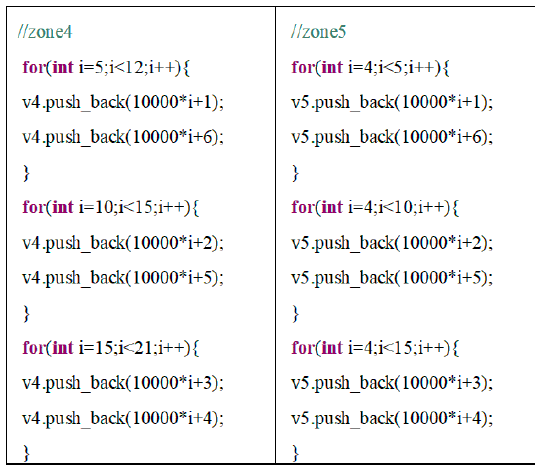
Figure 16. Optimal strategy seat number generation.